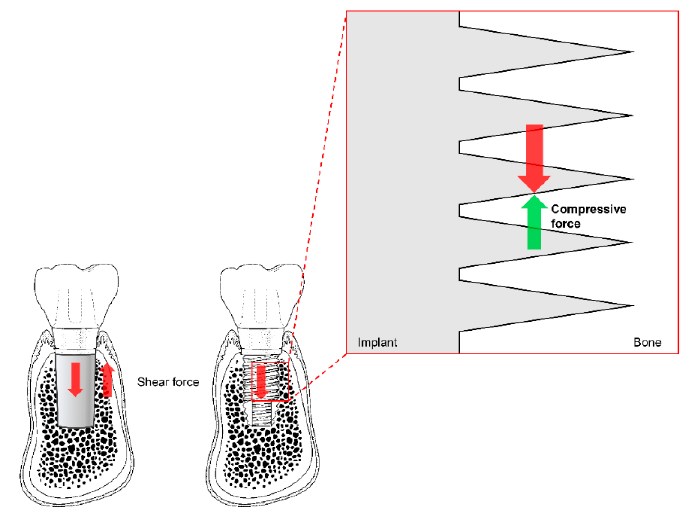
Figure 5. The thread function of non-threaded ( left ) and threaded ( right ) dental implants. Shear force (red arrows) is transformed into compressive force (green arrow) by the threads. Note the reduction of shear force due to the partial switch to compressive force in the magnified diagram (vertically and horizontally; not marked).